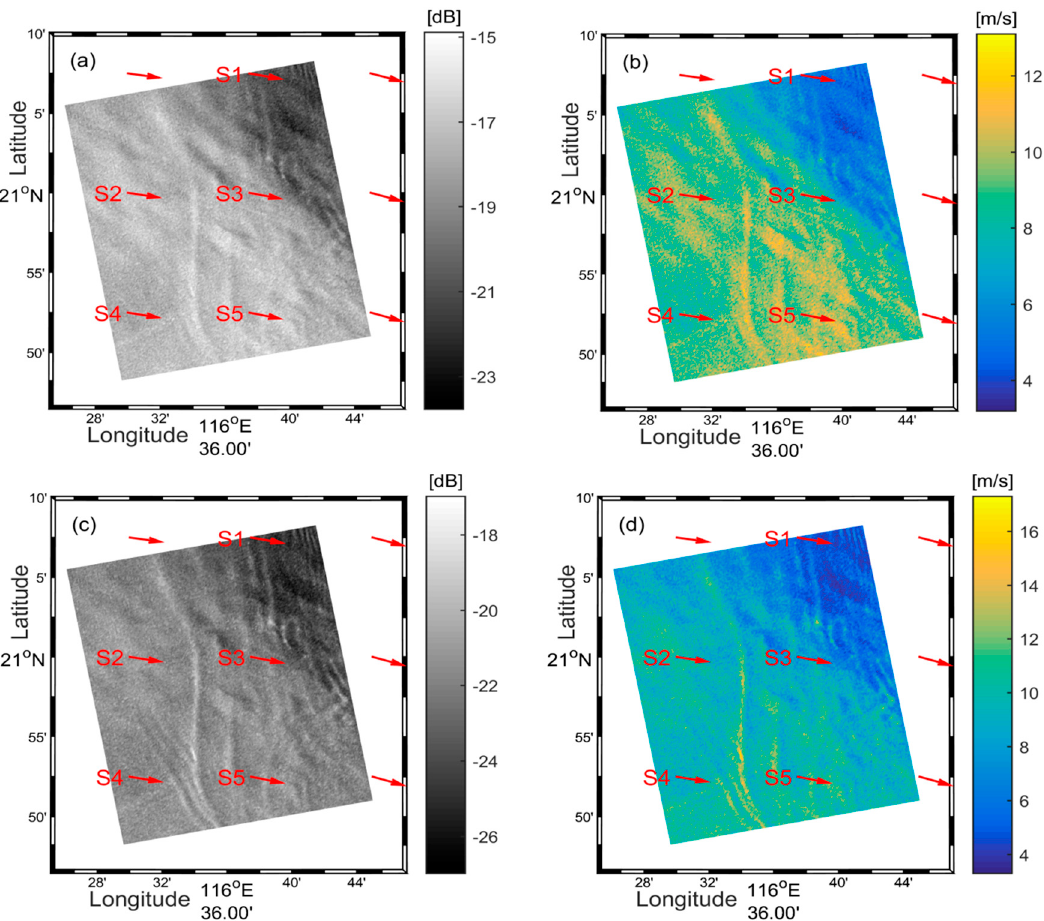
Figure 6. C-band ( a ) VV- and ( c ) HH-polarized SAR images in the South China Sea waters from RADARSAT-2 fine quad-polarization mode SLC SAR data acquired on 27 August 2012, at 10:25:24 UTC (grayscale and color bar denote NRCS). OSWS retrieved from CMOD using ( b ) VV and ( d ) HH-polarized imagery. Red arrows denote wind directions from ERA-Interim data. RADARSAT-2 Data and Product MacDonald, Detweiler and Associates Ltd., All Rights